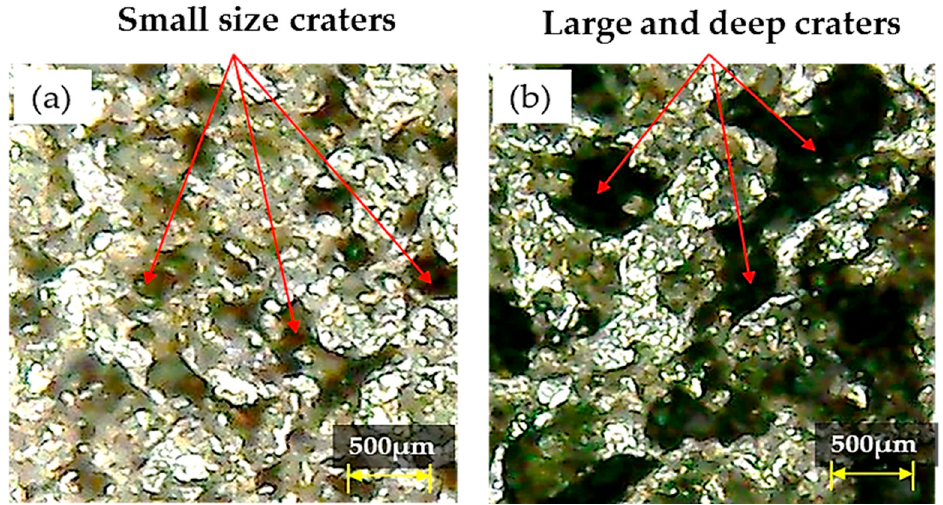
Figure 11. Micrographs showing size of craters in the specimen surface treated with brass electrode: ( a ) Small and deep craters formed at 6A discharge current; ( b ) Large and wide craters formed at 8 A discharge current.